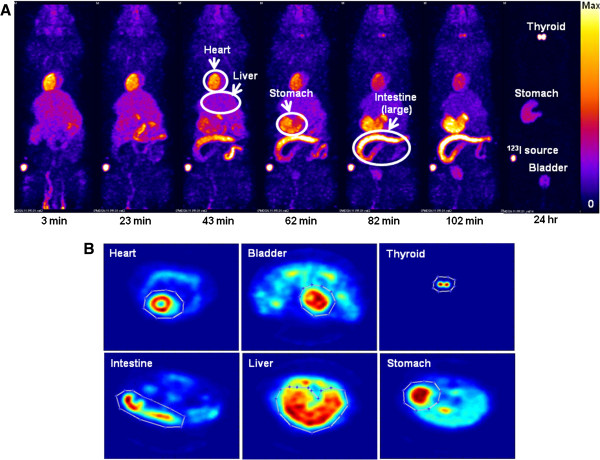
MicroSPECT images. A panel of coronal whole-body images of a healthy rat at 3, 23, 43, 62, 82, and 102 min and 24 h after the injection of 45 MBq 123I-CMICE-013 (A). The circled areas are indicated as the heart, liver, large intestine, and stomach. The bright spots in the 24-h image were identified as the thyroid, stomach, 123I source, and bladder. Volumes of interest (VOIs) for imaging biodistribution analysis were drawn around all areas of focal uptake in the 23- to 102-min summed images (B).